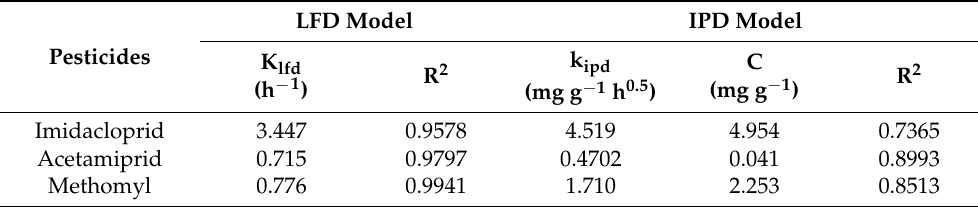
Figure 6. ( a ) Intra-particle diffusion model and ( b ) liquid film diffusion model fitting for the adsorp- tion of imidacloprid (IMI), methomyl (MET) and acetamiprid (ACE) on the BC material. Table 6. The kinetic parameters of the LFD and IPD models for imidacloprid (IMI), acetamiprid (ACE) and methomyl (MET) adsorption on BC.